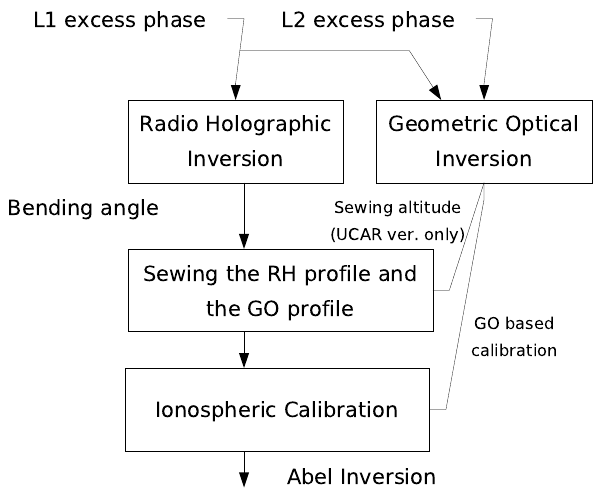
Fig. 1. Inversion scheme of GPS RO data by combining the GO and FSI